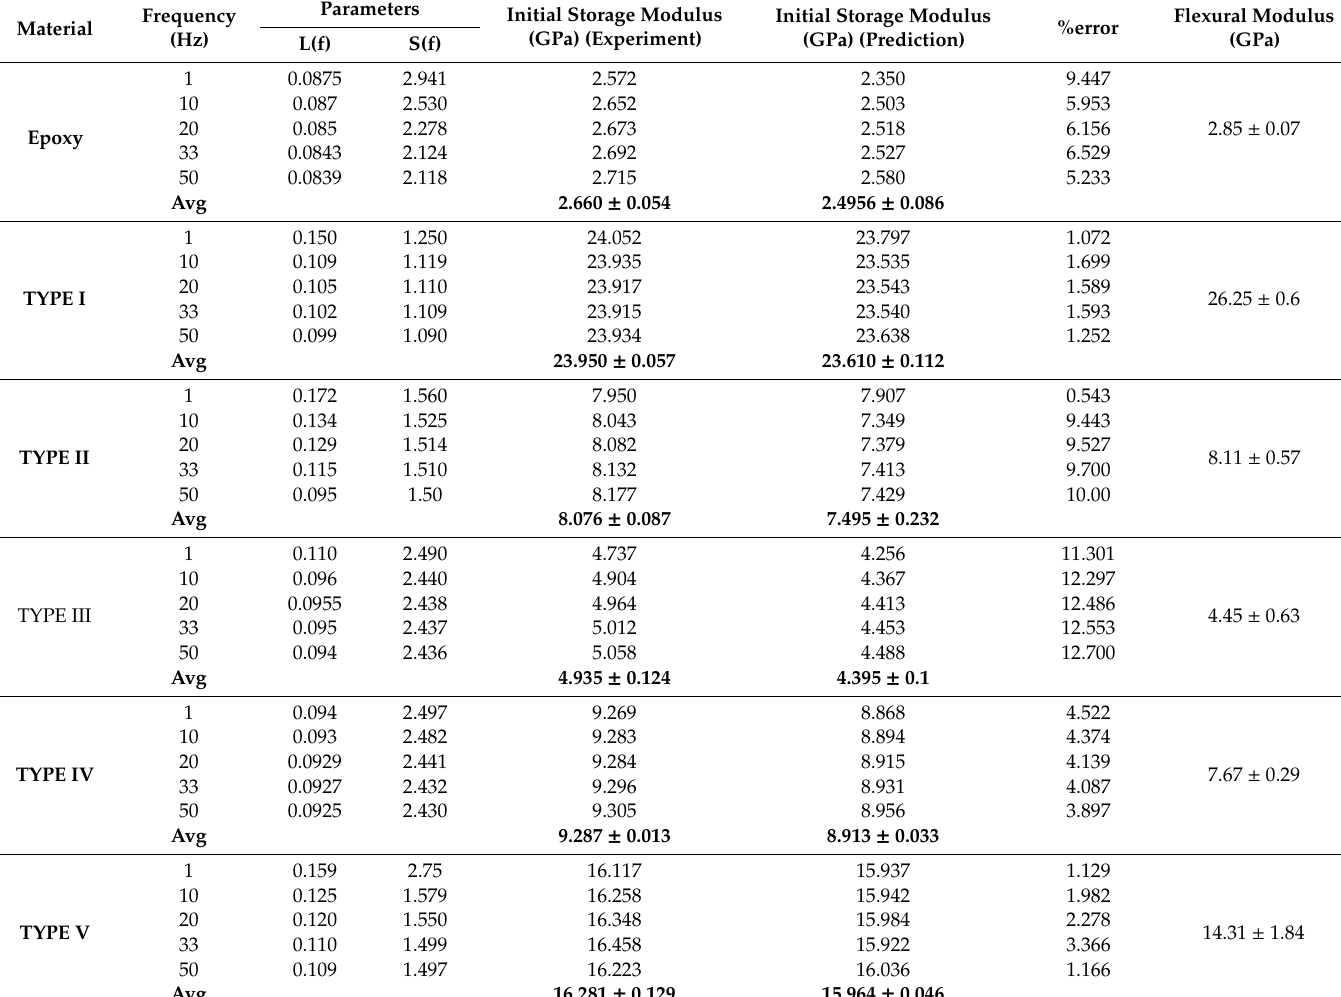
Table 1. The e ff ect of frequency on initial storage modulus of epoxy and glass / epoxy